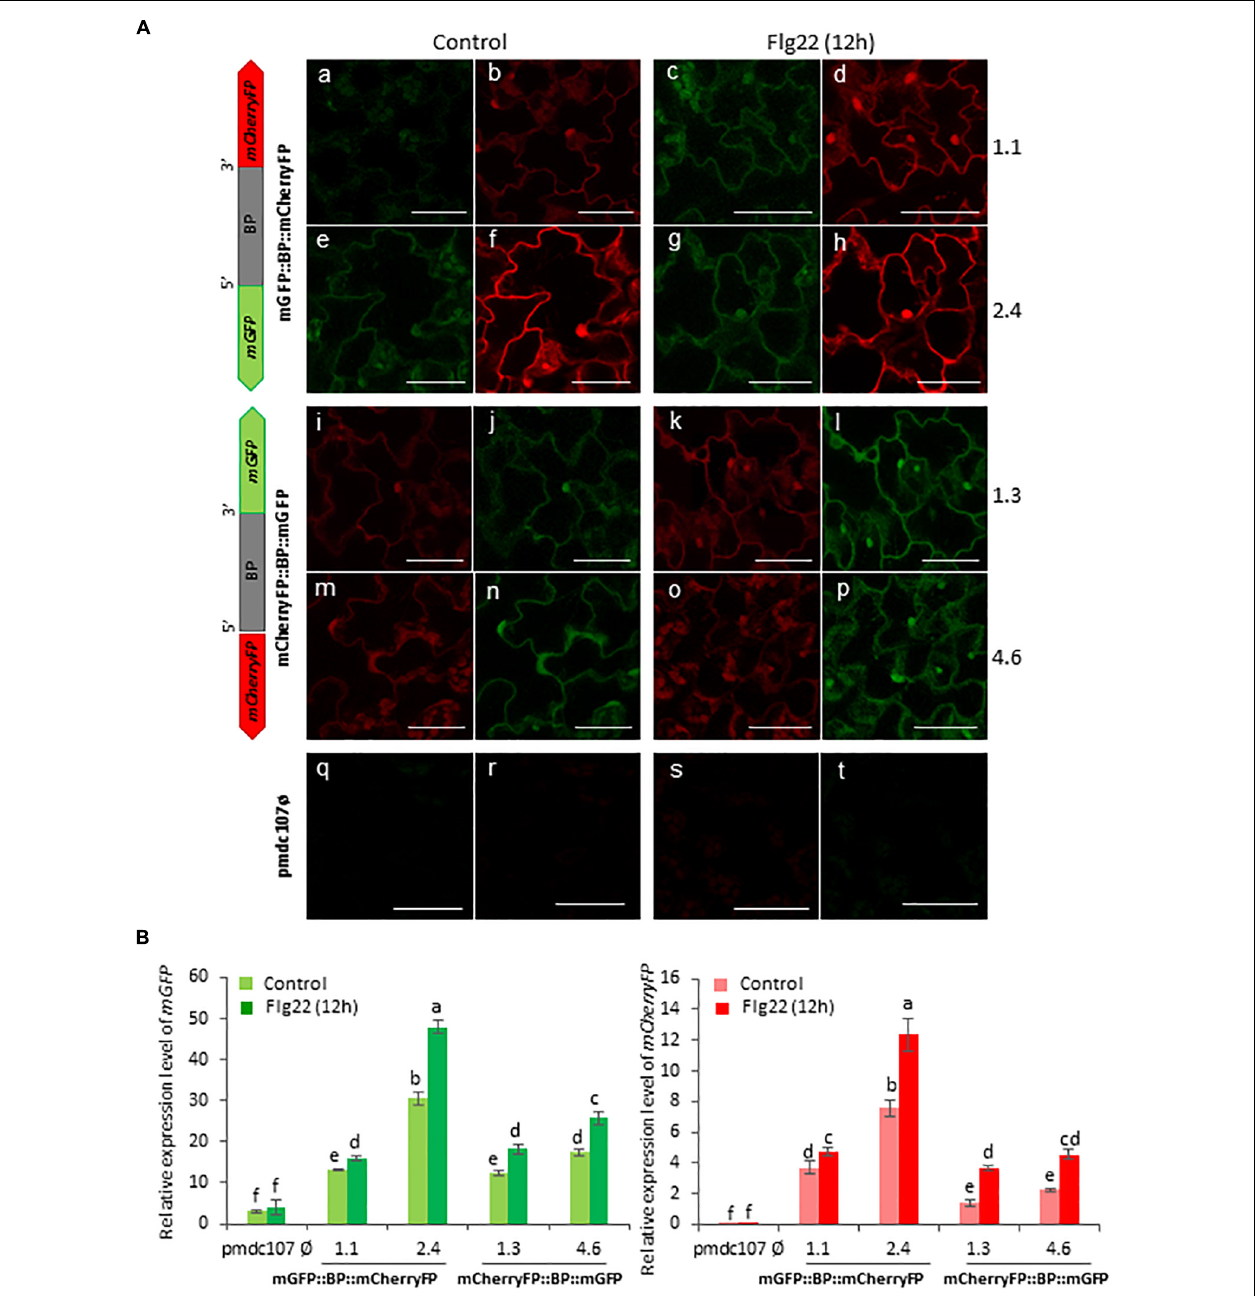
FIGURE 7 | Schematic representation of fusion-constructs and expression assays in stably transformed Arabidopsis plants in response to flagellin treatment. (A) Scheme of mCherryFP and mGFP genes driven by the bidirectional promoter (BD) and confocal stacks spanning Arabidopsis epidermal cells of transformed plants after 1 ◦ h offlagelin22 (Flg22) treatment. Projections are from mCherryFP (b,d,f,h,i,k,m,o,r,t) and mGFP (a,c,e,g,j,l,n,p,q,s) . Bars are 50 µ m. (B) Quantitative analyses of mGFP and mCherryFP expression by RT-qPCR in Arabidopsis transformed plants after 1 h of Flg22 treatment. Bars in green and red colors correspond to mGFP and mCherryFP gene expression, respectively. Data are ± SE of three biological replicates. Differential letters indicate statistical differences ( P < 0.05 Wald χ 2 followed by LSD test). Arabidopsis selected lines for mGP::BBP::mCherryFP construct were 1.1. and 2.4, and for mCherryFP::BD::mGFP were 1.3 and 4.6. Primers used for this experiment are listed in Supplementary Table 1